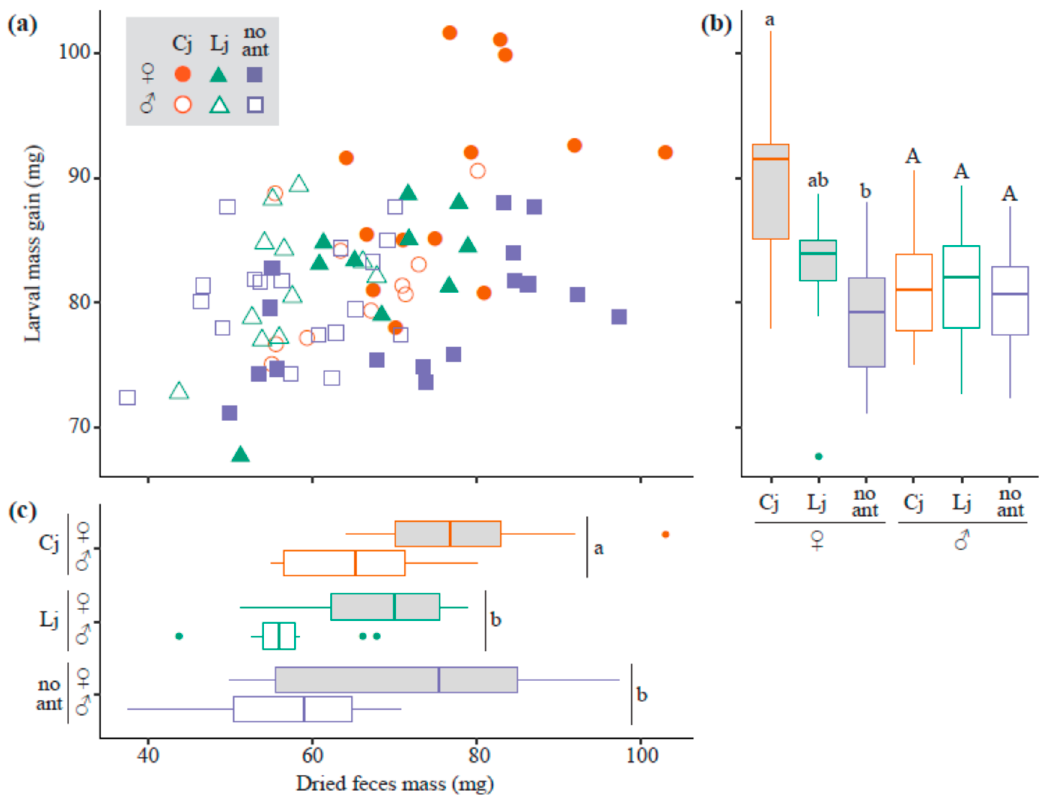
Figure 1. Larval mass gain and feces mass. A scatter plot shows the relationship between larval mass gain and dried feces mass ( a ). Orange circle, green triangle, and blue square symbols represent larvae tended by C. japonicus (Cj), by L. japonicus (Lj), and untended larvae (no ant), respectively. Solid and open symbols represent female and male larvae, respectively. Box plots show larval mass gain ( b ) and dried feces mass ( c ) between ant-tending conditions (Cj: orange, Lj: green, no ant: blue) and lycaenid sex (female: gray boxes, male: white boxes). Different letters represent significant differences.